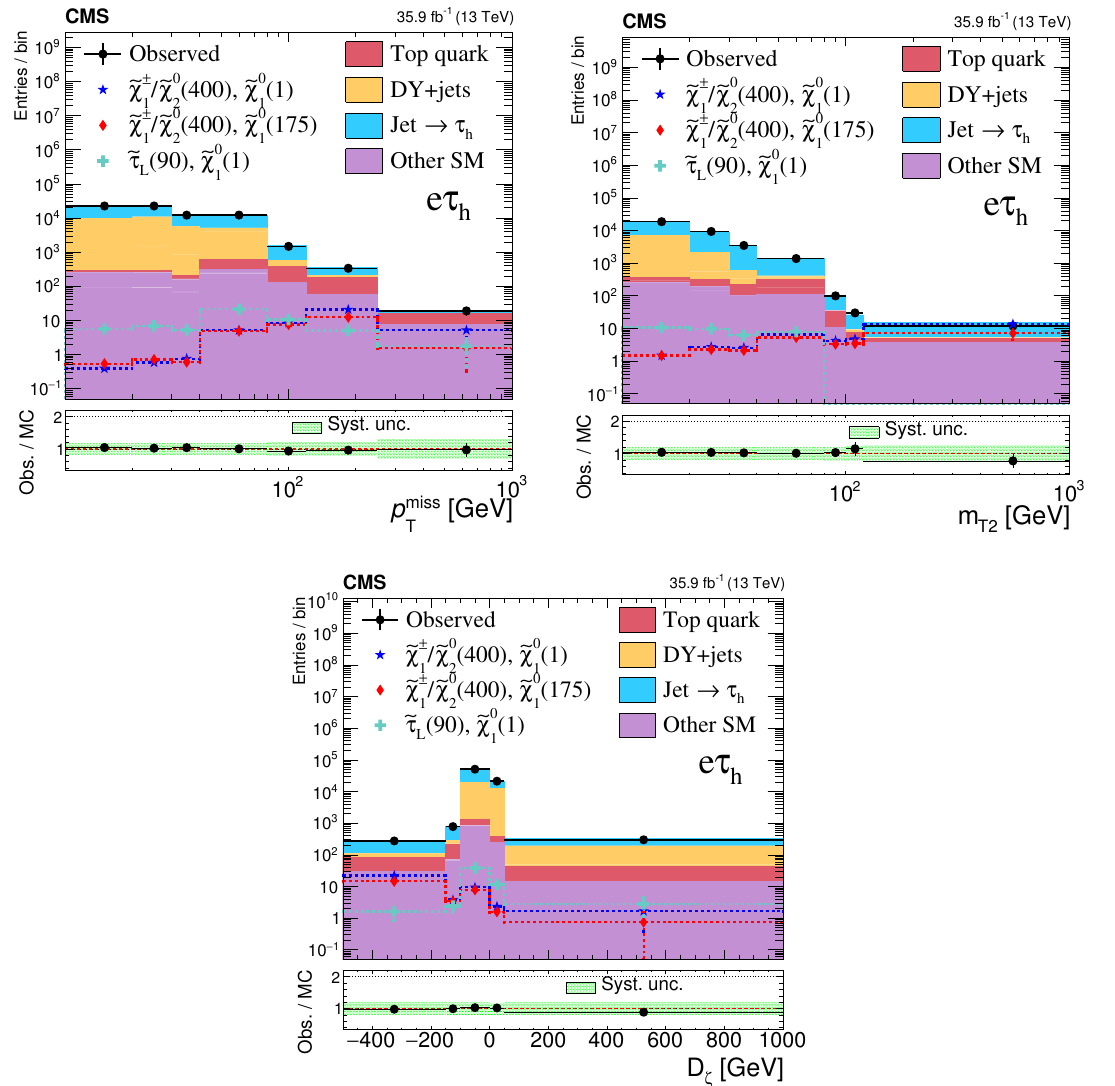
Figure 5. Distributions of the search variables p miss (top left), m T2 (top right), and D (cid:16) (bottom) T for the e (cid:28) h (cid:12)nal state for events after the baseline selection. The black points show the data. The background estimates are represented with stacked histograms. Distributions for two benchmark models of chargino-neutralino production, and one of direct left-handed (cid:28) pair production, are overlaid. The numbers within parentheses in the legend correspond to the masses of the parent SUSY particle and the (cid:31) 0 in GeV for these benchmark models. In all cases, the last bin includes e 1 e